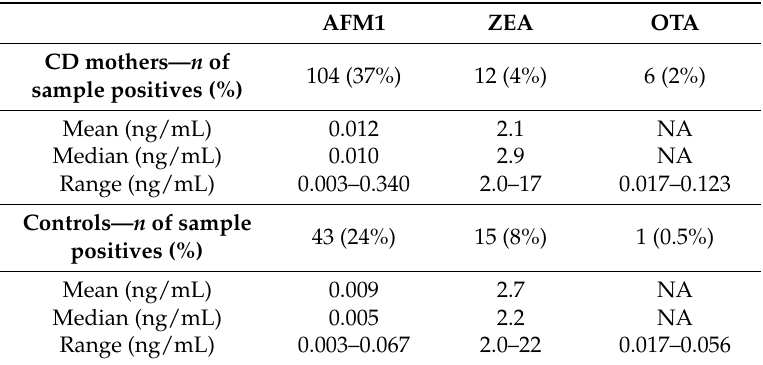
Table 2. Presence of the three studied mycotoxins from both groups. Overall, 453 samples were suitable for analysis: 275 from CD mothers and 178 from control mothers. AFM1